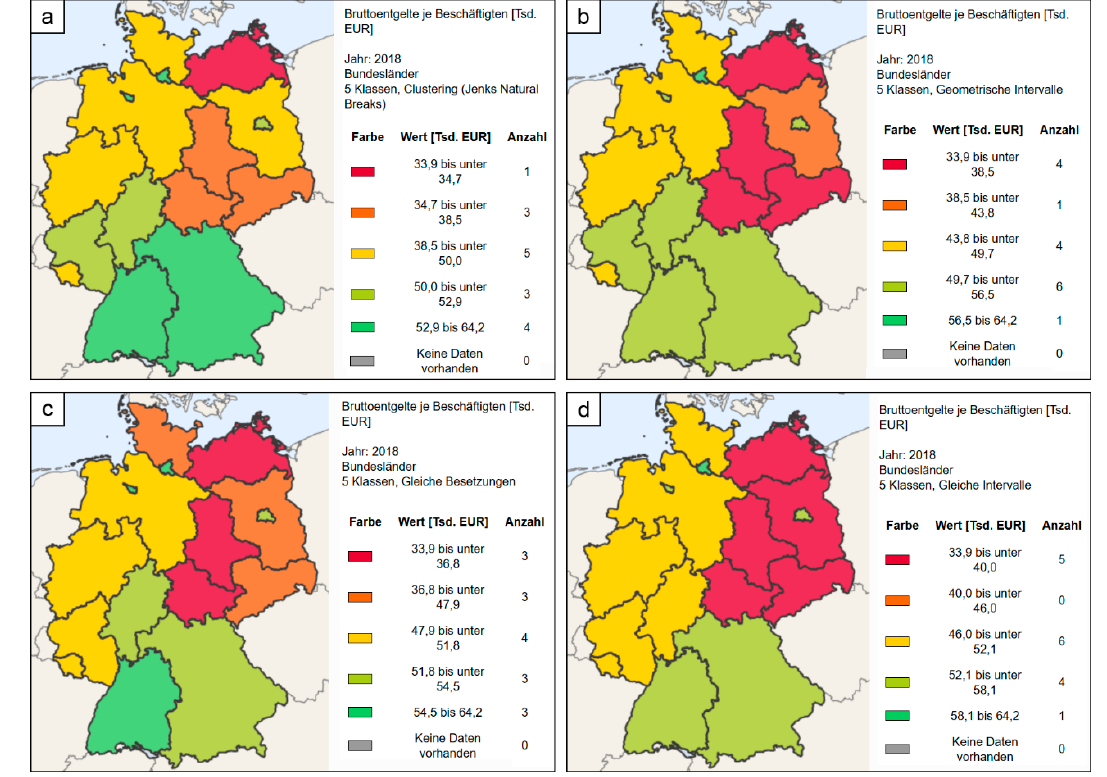
Figure 10. Gross income per capita in German states 2018 in six classes; classification is based ( a ) on natural breaks (Jenks), ( b ) on geometric interval, ( c ) on equal number of cases per class (quantiles) and ( d ) on equal intervals per class [28] (Data licence Germany – destatis – Version 2.0). (Legend shows color, value ranges and number of cases per class).